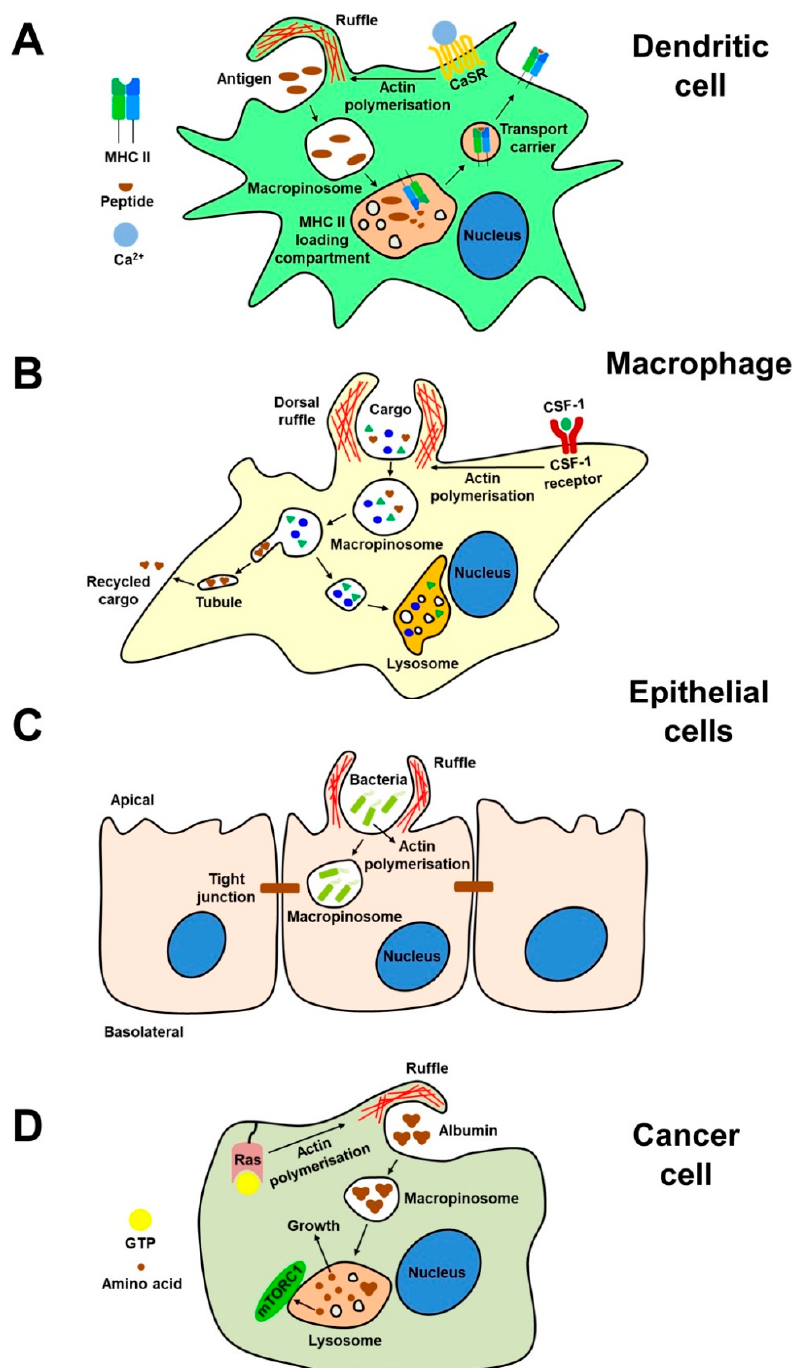
Figure 1. Macropinocytosis in di ff erent cell types. ( A ) Dendritic cells use constitutive macropinocytosis to internalise antigens that are subsequently tra ffi cked to MHC II-positive compartments. ( B ) Macrophages can internalise substantial amounts of extracellular fluid and solutes in response to growth factor stimulation, which are tra ffi cked to lysosomes or alternatively recycled to the cell surface via tubular carriers. ( C ) Epithelial cells show low levels of macropinocytosis at rest, but pathogens such as bacteria can induce macropinocytosis to facilitate their internalisation. ( D ) Cancer cells expressing oncogenic Ras constitutively macropinocytose, which facilitates the uptake of extracellular nutrients which activate mTOR signalling and drive growth and proliferation.